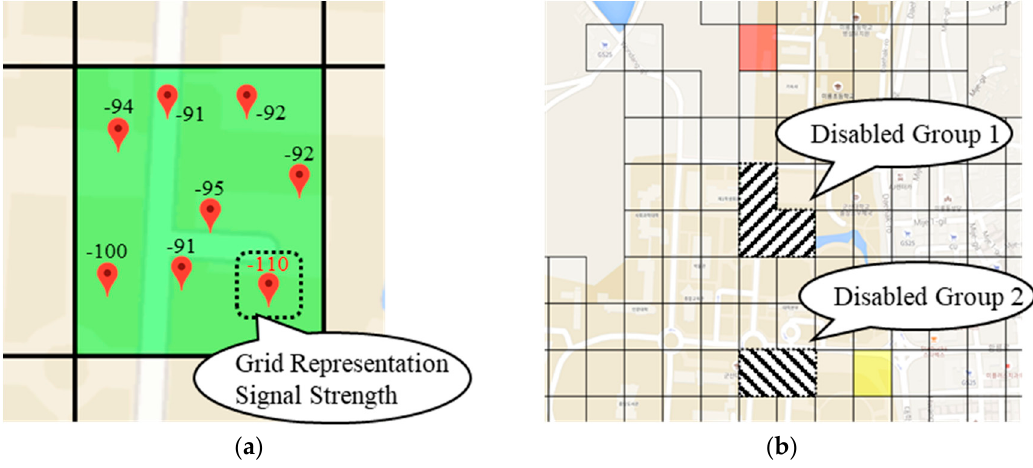
Figure 6. Examples of ( a ) determining service-disabled grid and ( b ) grouping service-disabled grid.